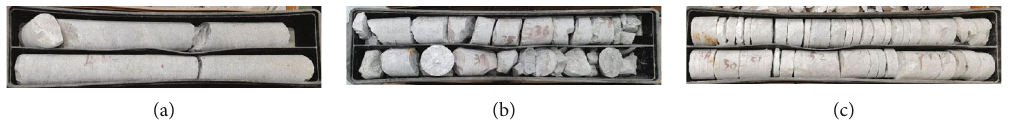
Figure 1: Typical core discs of Jinping marble at di ff erent depths. (a) Depth 1400 m. (b) Depth 1800 m. (c) Depth 2400m.